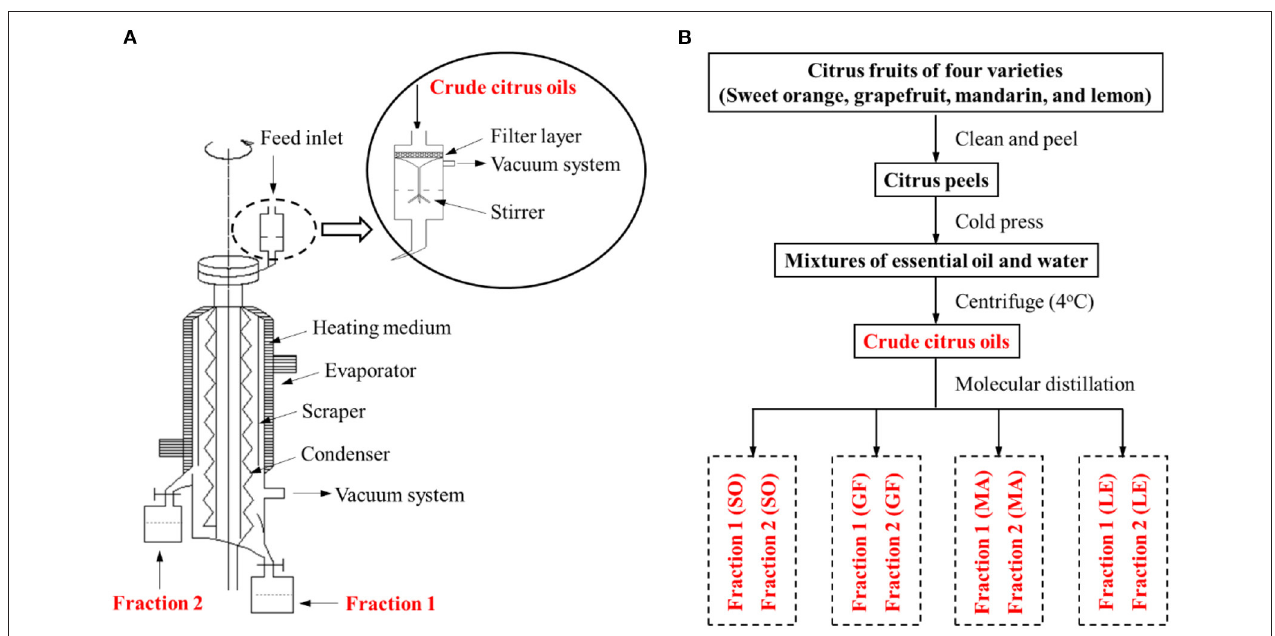
FIGURE 1 | (A) Schematic diagram of our molecular distillation apparatus. (B) Flow chart of the extraction and separation of citrus essential oils (EOs) from sweet orange (SO), grapefruit (GF), mandarin (MA), and lemon (LE).